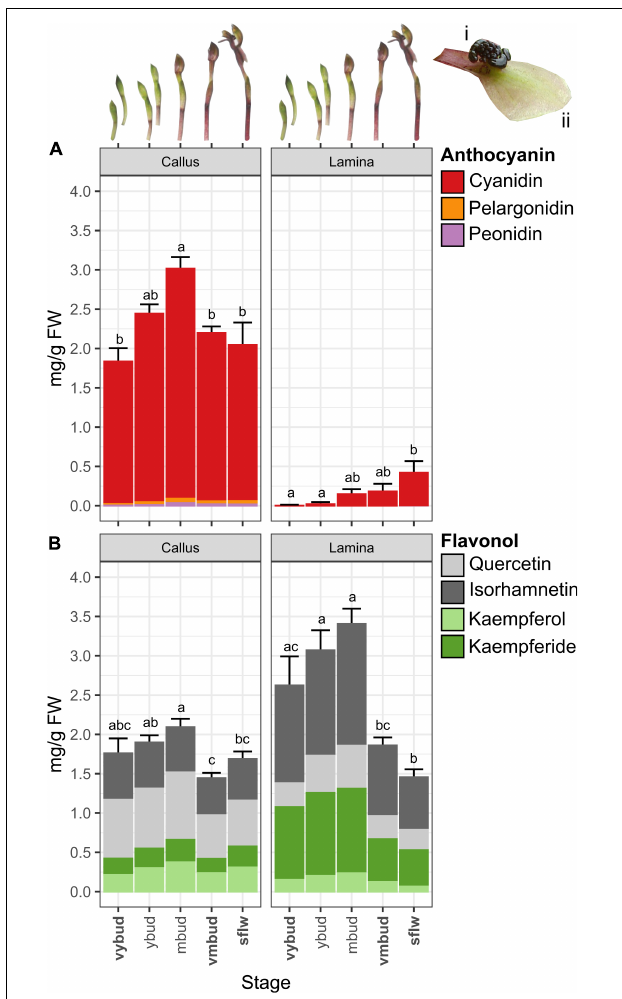
FIGURE 2 | Changes in anthocyanins and flavonol glycoside co-pigments of Chiloglottis trapeziformis flowers. Bar graphs depict the total (A) anthocyanin and (B) flavonol glycoside content (average ± s.e.) in the callus and labellum lamina (see insets i and ii) of Chiloglottis trapeziformis flowers at different developmental stages (i.e., very young bud, vyb ; young bud, yb ; mature buds, mb ; very mature bud, vmb ; and naturally opened flowers in the field, sflw ). Bold indicates developmental stages with corresponding transcriptome profiled. Labels not connected by the same letter are significantly different at P < 0.05 based on ANOVA and Tukey HSD test (see Supplementary Figure 7 for further